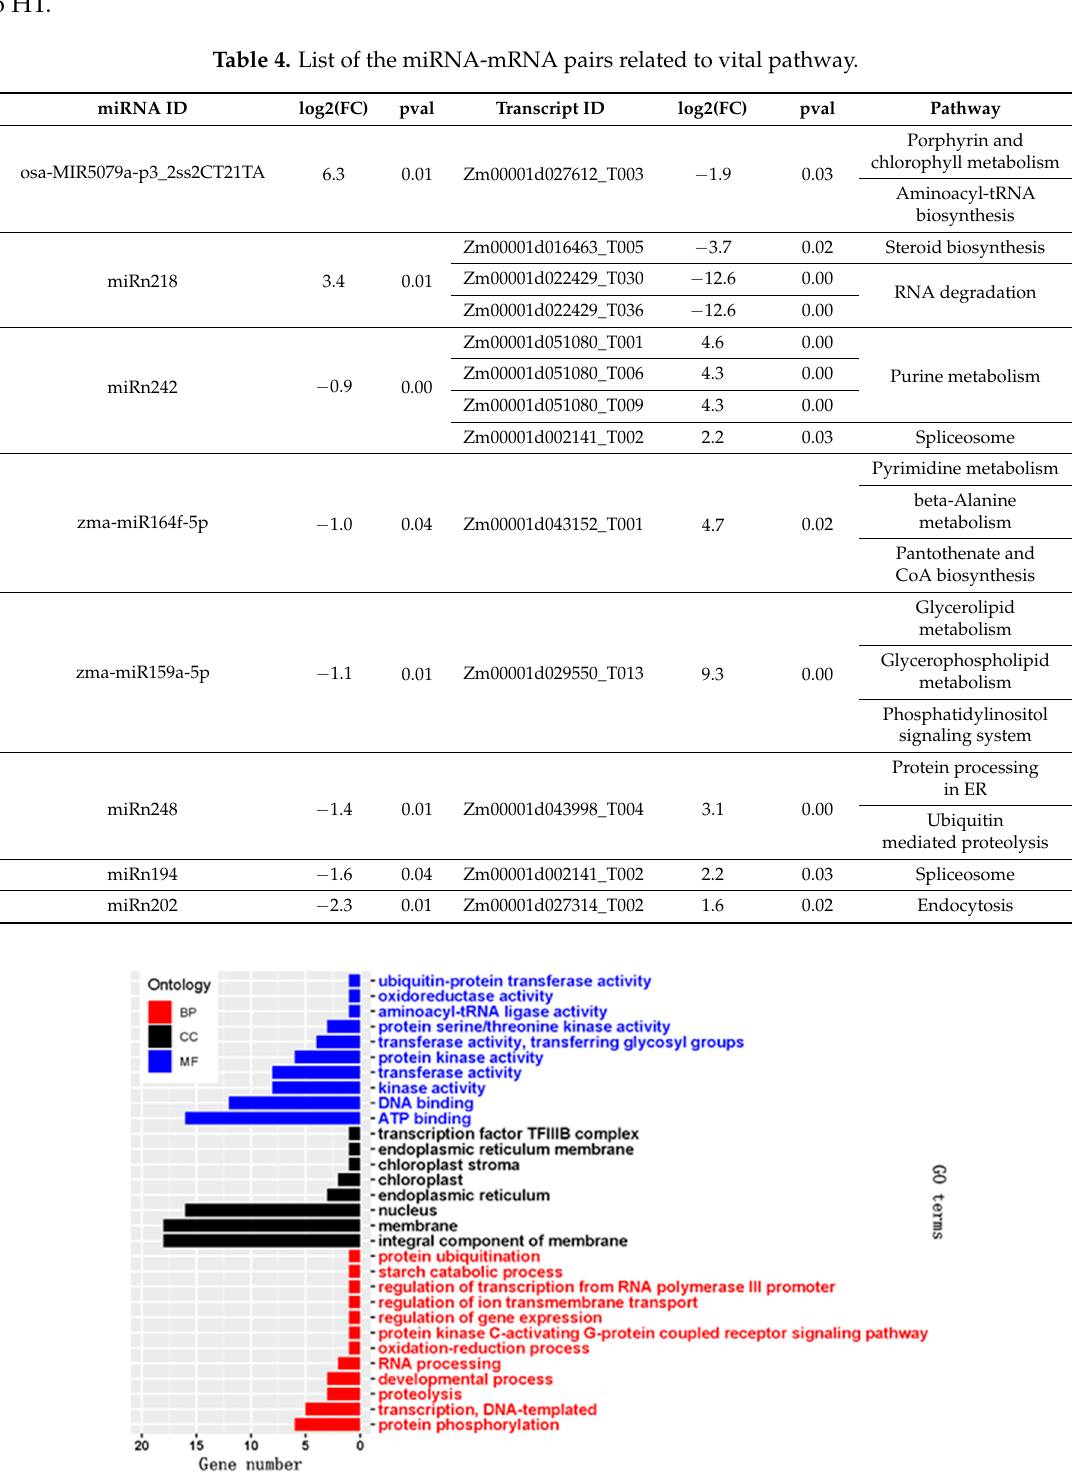
Figure 6. The GO terms in red, black, and blue belong to biological processes, cellular components, and molecular functions, respectively, enriched by target mRNAs negatively regulated by DEMs.